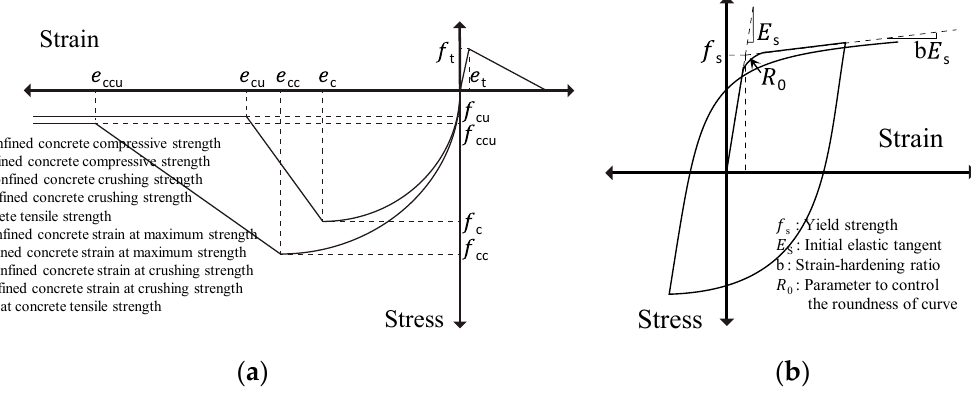
Figure 4. Modeling of structural elements: ( a ) columns and beams; ( b ) T-shaped beams; and ( c ) rules pertaining to fiber representations.